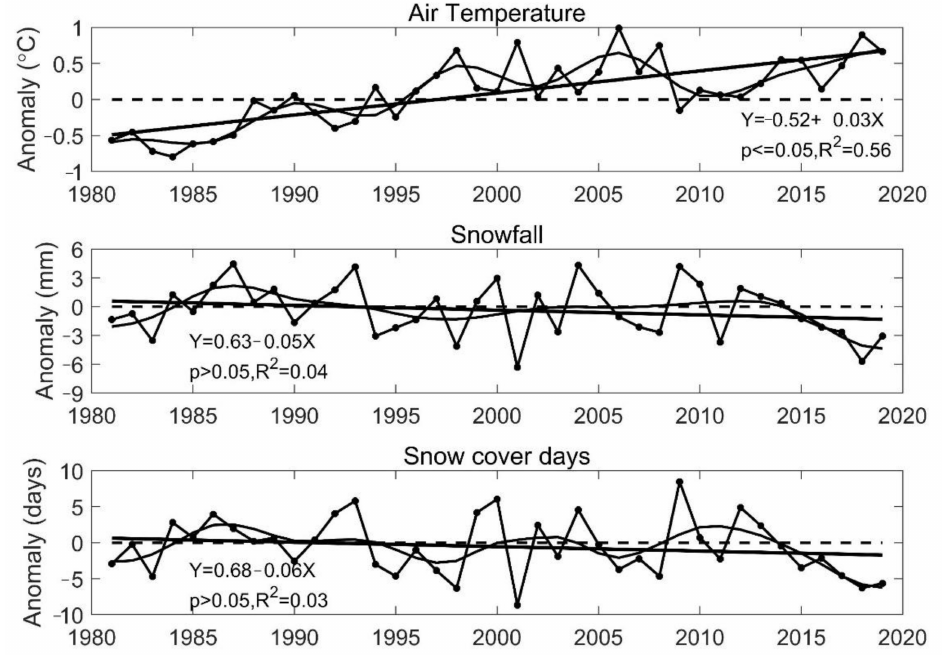
Figure 4. Interannual variations of annual mean air temperature, snowfall, and snow cover days from 1981 to 2019 with respect to the 1981–2010 mean across